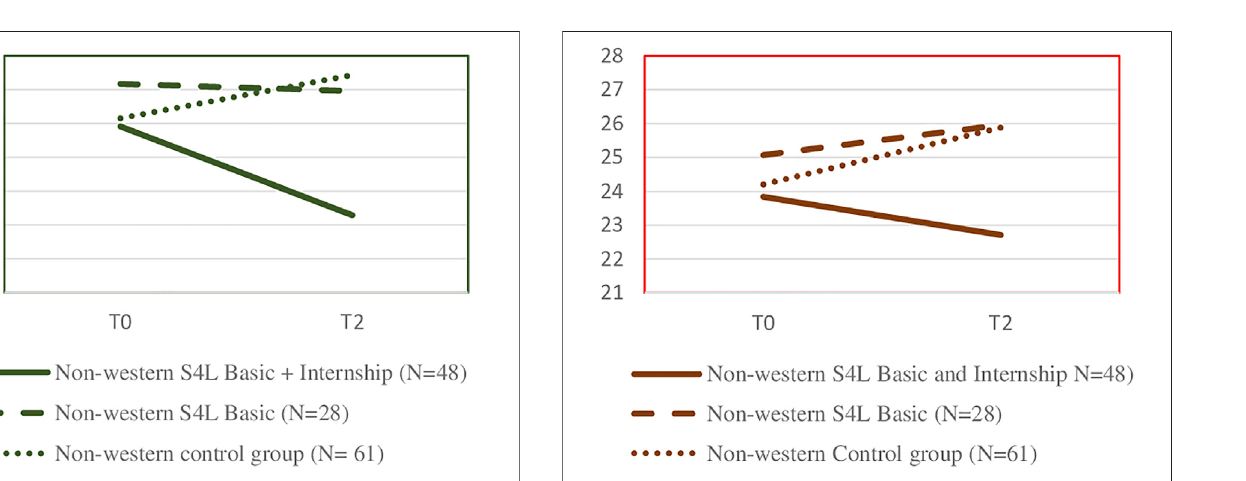
FIGURE 4 | Social Awareness T0 – T2 Non-western students (Means). Note: Non-Western (cid:1) Students who identify themselves as having non- western background (e.g., Turkish, Moroccan, Cape Verdean, Pakistani, or Somali); S4L-basc +internship: Students exposed tothe S4L-basicand the S4L-intership module; S4L-basic: Students exposed to the S4L-basic module alone; Control group: Students in the Waitlist Control group.